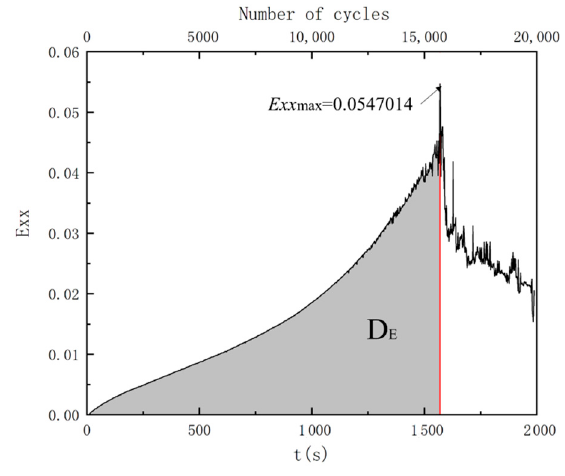
Figure 8. Variation curve of horizontal strain with loading time/times of repeated load.